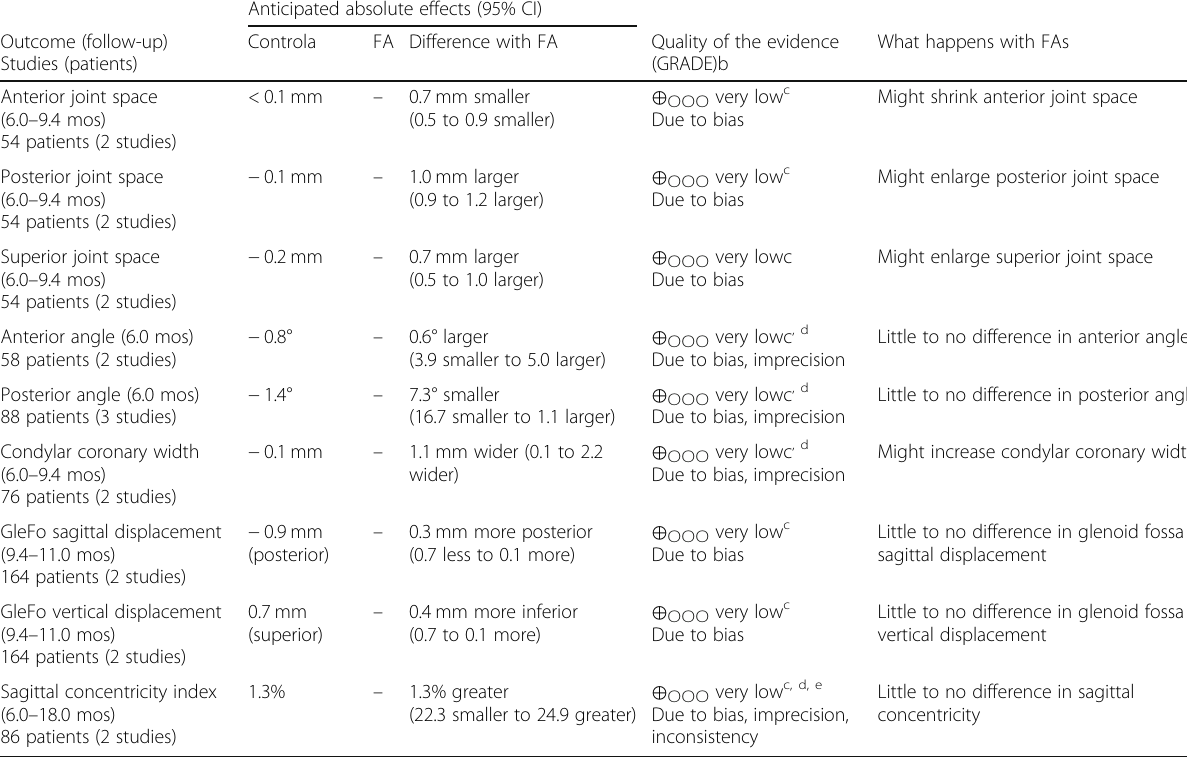
Table 5 Summary of findings table according to the GRADE